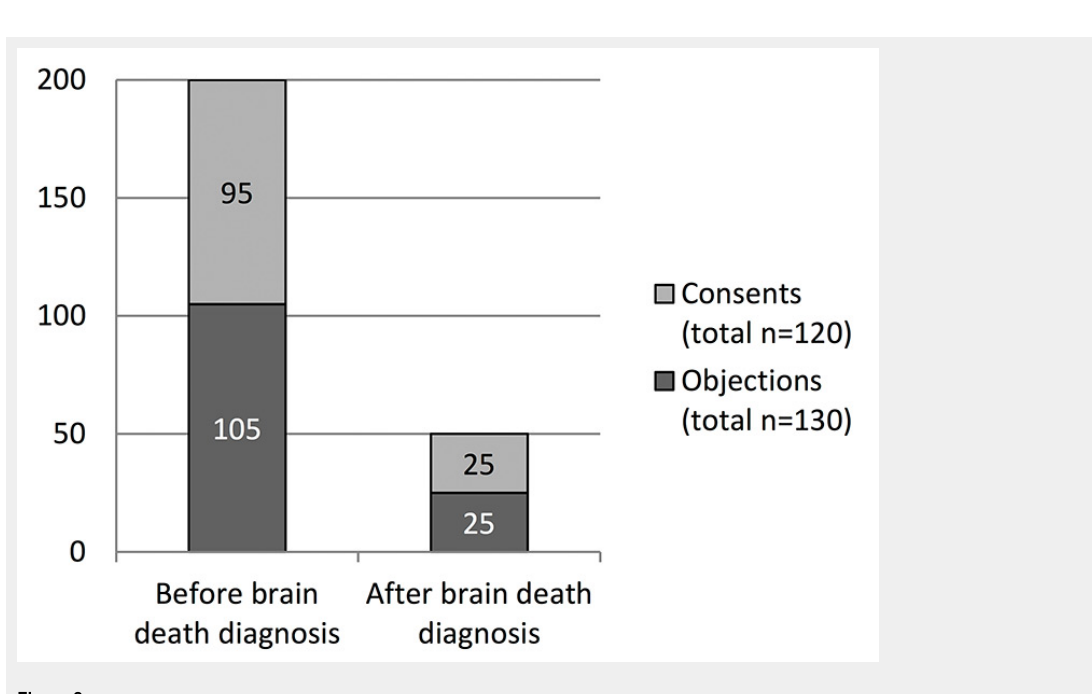
Figure 2 Consent vs objection to